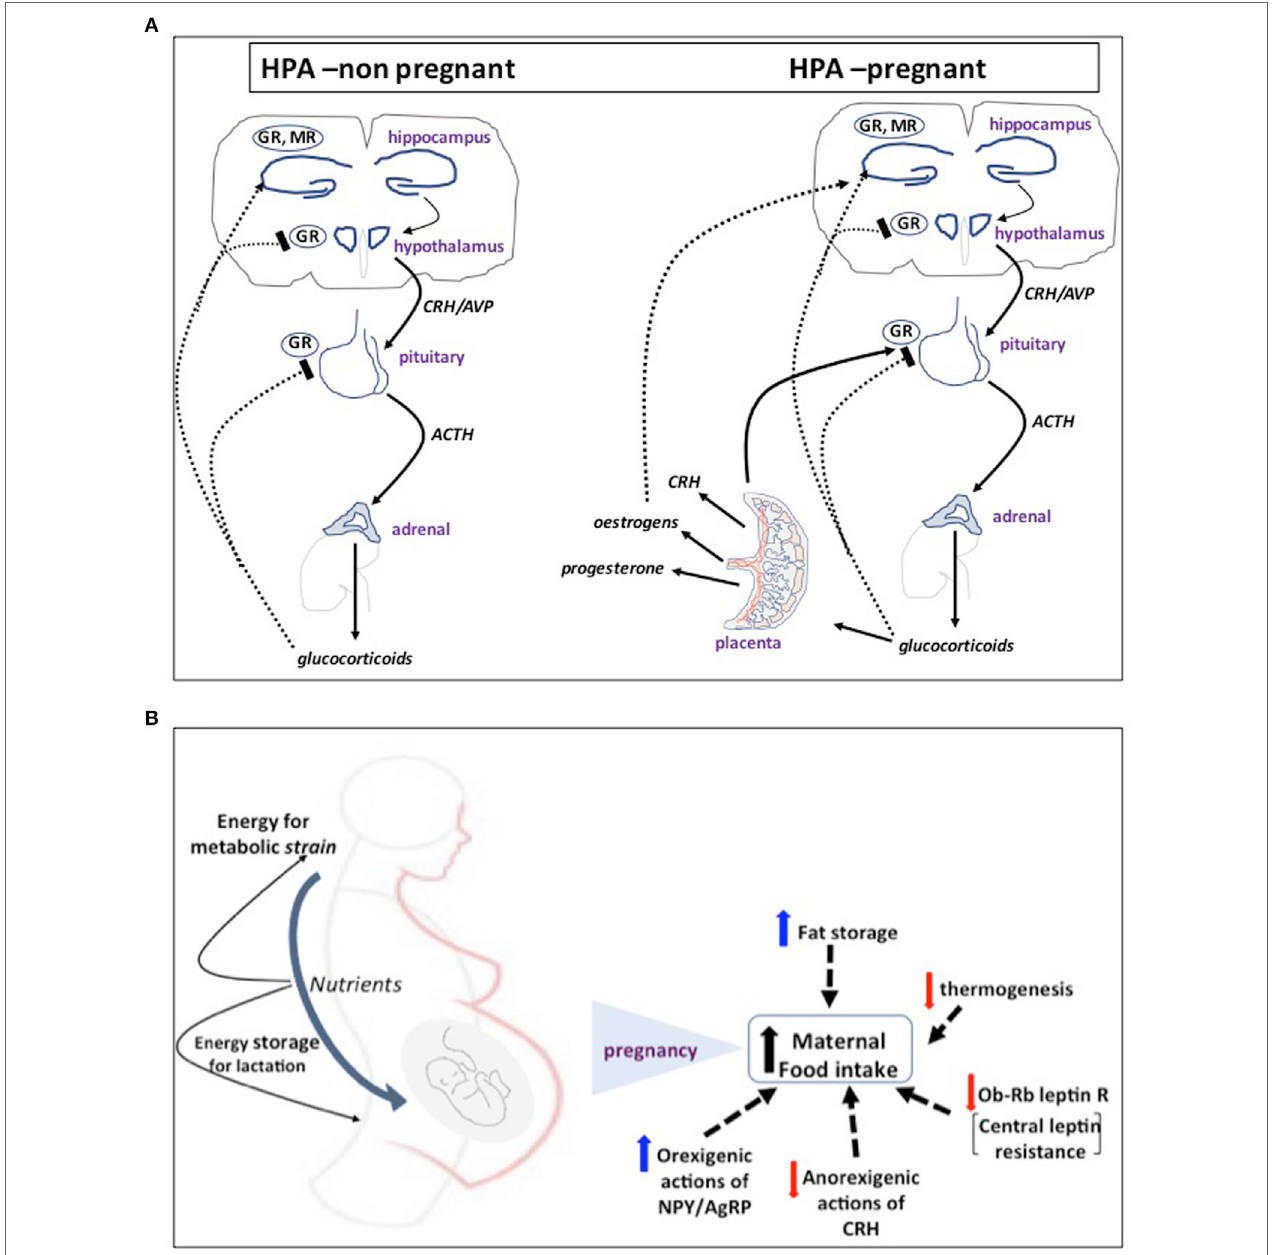
FigURe 1 | (A) The first step of mammalian hypothalamo-pituitary adrenal (HPA) axis activation in response to psychological or physical stressors involves activation of neurosecretory corticotropin-releasing hormone (CRH) neurons in the hypothalamic paraventricular nucleus. CRH and AVP released into the hypophysial portal blood system stimulate adrenocorticotropic hormone (ACTH) release from anterior pituitary corticotrophs and, in turn, the adrenal to secrete glucocorticoids (corticosterone in rodents) into the bloodstream. Cortisol tightly controls HPA activity by feeding back to glucocorticoid receptors (GR) and mineralocorticoid receptors (MR) in the pituitary and hypothalamus to turn-off CRH release and its own secretion. In humans and higher primate pregnancy, placenta secretes large quantities of CRH into the maternal bloodstream during the second and third trimesters of pregnancy. Placental CRH secretion is augmented by cortisol, thus providing a unique positive feedback loop extension to the feto-maternal stress axis that sustains high levels of CRH secretion throughout pregnancy. (B) In response to increased energy demands of mother and fetus, food intake increases in pregnancy by resetting central appetite-control mechanisms. A key molecular event appears to be altered leptin signaling and development of central leptin resistance. This is primarily due to decreased expression of the Ob-Rb leptin receptor in the ventromedial hypothalamus and reduced signaling activity despite increased concentration of circulating leptin as a result of expansion of the adipose tissue with contribution from placental secretion. This is coupled with differential regulation of central actions of other orexigenic and anorexigenic hormones and neurosteroids, such as CRH, NPY and AgRP, progesterone, and allopregnanolone that shift the balance toward increased appetite and food intake and fat storage and decreased thermogenesis. These mechanisms ensure that there are sufficient nutrients for the fetus, sufficient energy for the extra metabolic strain on the mother, and a surplus of energy that can be stored as fat in preparation for lactation.